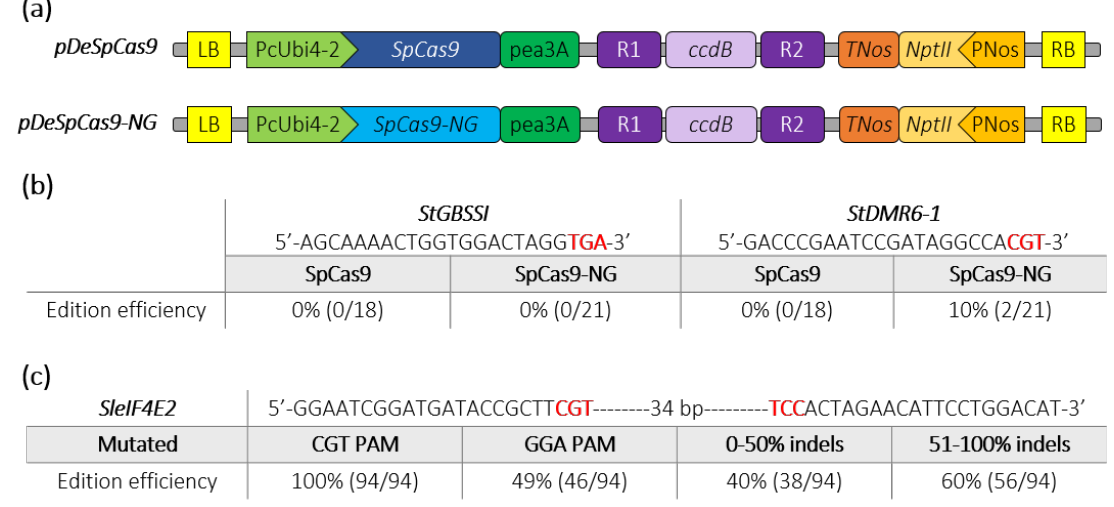
Figure 2. Schematic representation of SpCas9 and SpCas9-NG binary plasmids and editing efficiencies in potato and tomato. ( a ) The construct backbones used for Agrobacterium -mediated transformation of potato (Desiree) and tomato (WVA106) are schematically represented. The R1_ccdB_R2 cassette allows the insertion of the guide cassette through a Gateway LR reaction. ( b ) Edition efficiency represents the percentage of mutated potato plants among the transgenic plants. The PAM sequence is depicted in bold red. ( c ) Among the mutated tomato plants screened by HRM, 94 plants were Sanger sequenced and analyzed using ICE analysis. Edition efficiency represents the percentage of mutated plants with the SpCas9-NG at the SleIF4E2 locus for each target (CGT or GGA PAMs). The mutated plants are classified into two groups according to the rate of indels at the targeted eIF4E2 locus. The PAM sequence is depicted in bold red.